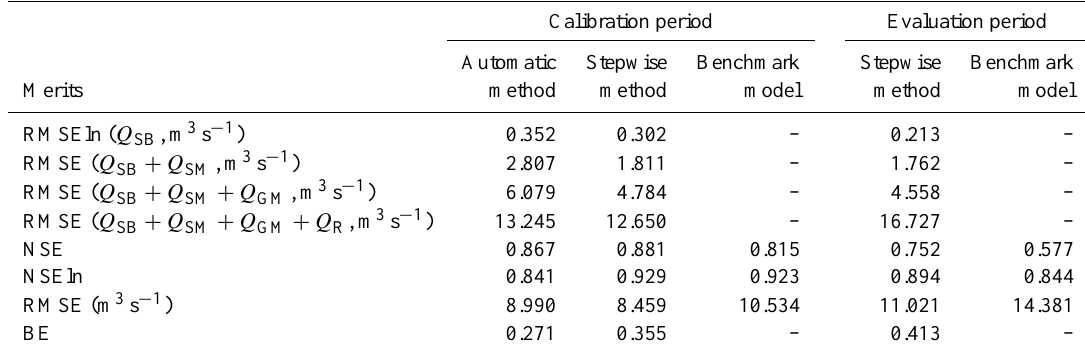
Table 5. Evaluation merits for the stepwise and automatic calibration